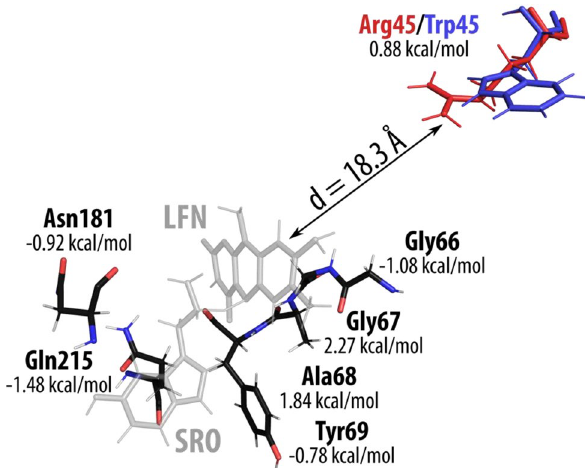
Figure 5. Residues with the largest difference in their barrier-lowering contribution between WT and R45W �� G ‡ elec ( x ) (cid:31) (i.e., (cid:31) > 0.5 kcal/mol)—a positive value of �� G (cid:31) (cid:31) out of the two, while a negative value means the opposite. Reacting serotonin (SRO) and lumiflavin (LFN) are (cid:31) (cid:31) shown in grey, with the mutated residue (WT Arg45 in red and R45W Trp45 in blue) located at a distance of 18 Å from the reacting